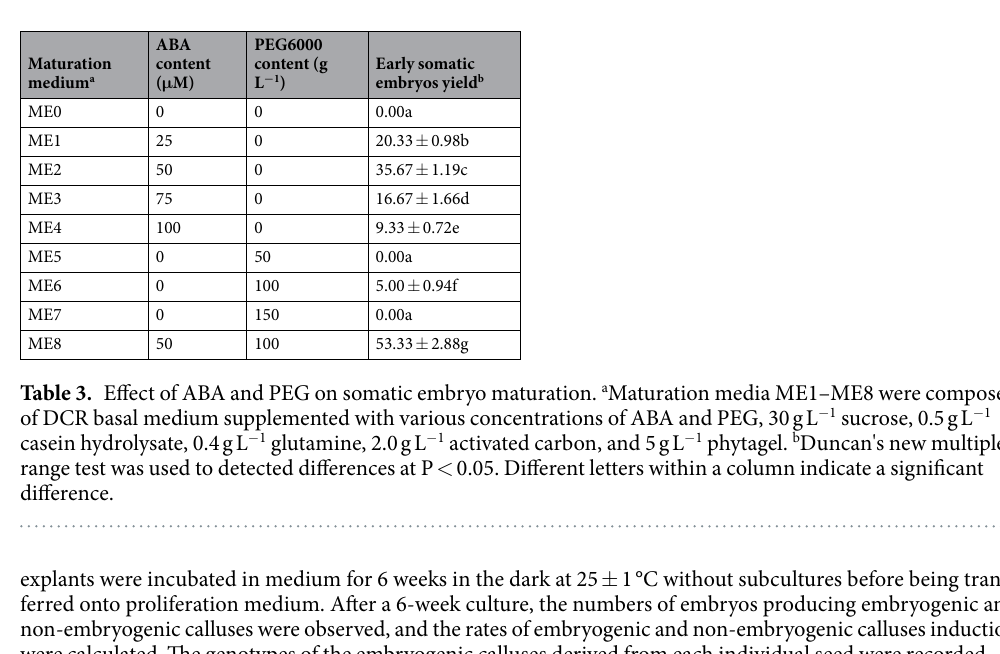
(Table 3). Four concentrations of ABA (25, 50, 75, and 100 μ mol L − 1 ) were added to DCR medium to deter-